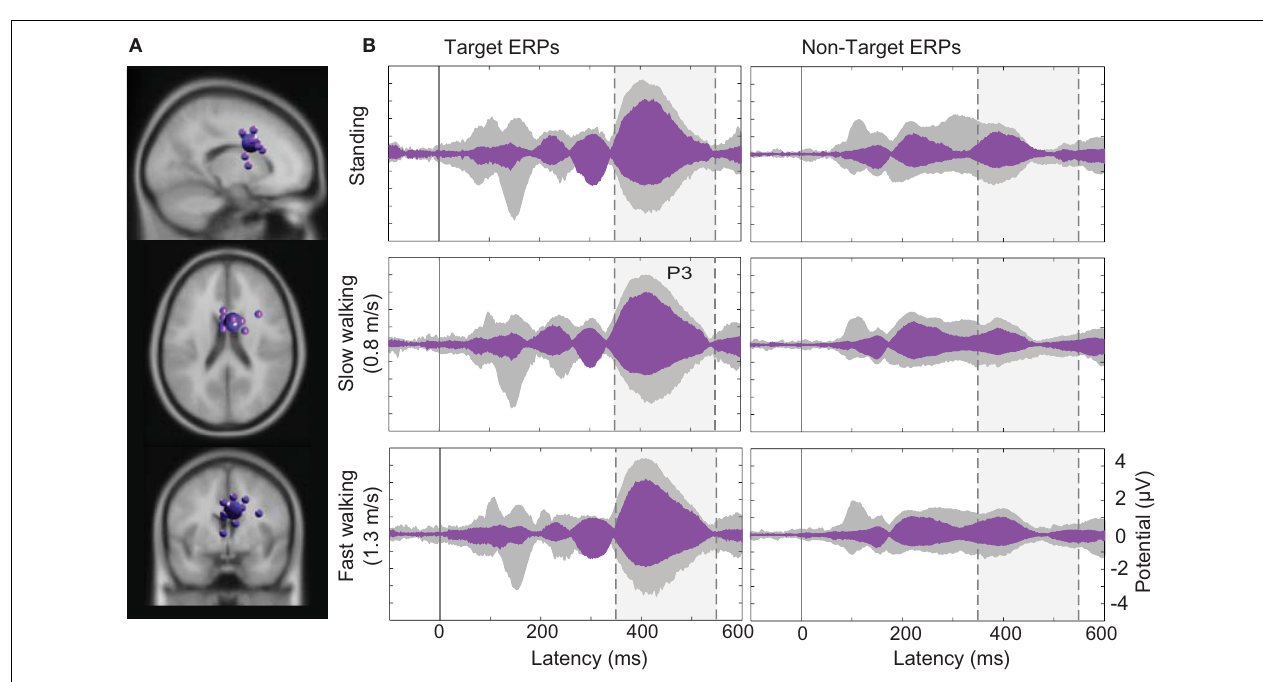
FIGURE 7 | (A) Centroid (bigger sphere) and individual ICs (12 ICs from 10 subjects displayed as smaller spheres) in or near superior parietal cortex (BA7) projected onto the standard MNI brain volume. (B) Target and non-target stimulus ERPs (middle and right columns) in the (dashed/shaded) P1-N1 latency